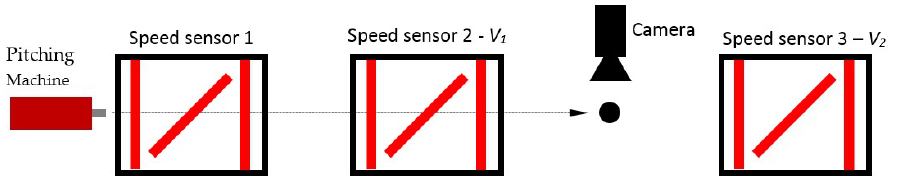
Figure 2. Arrangement of pitching machine, speed sensors and camera to measure ball speed, rotation and location. Gate aligned vertically measured ball speed while angled gates measured position.